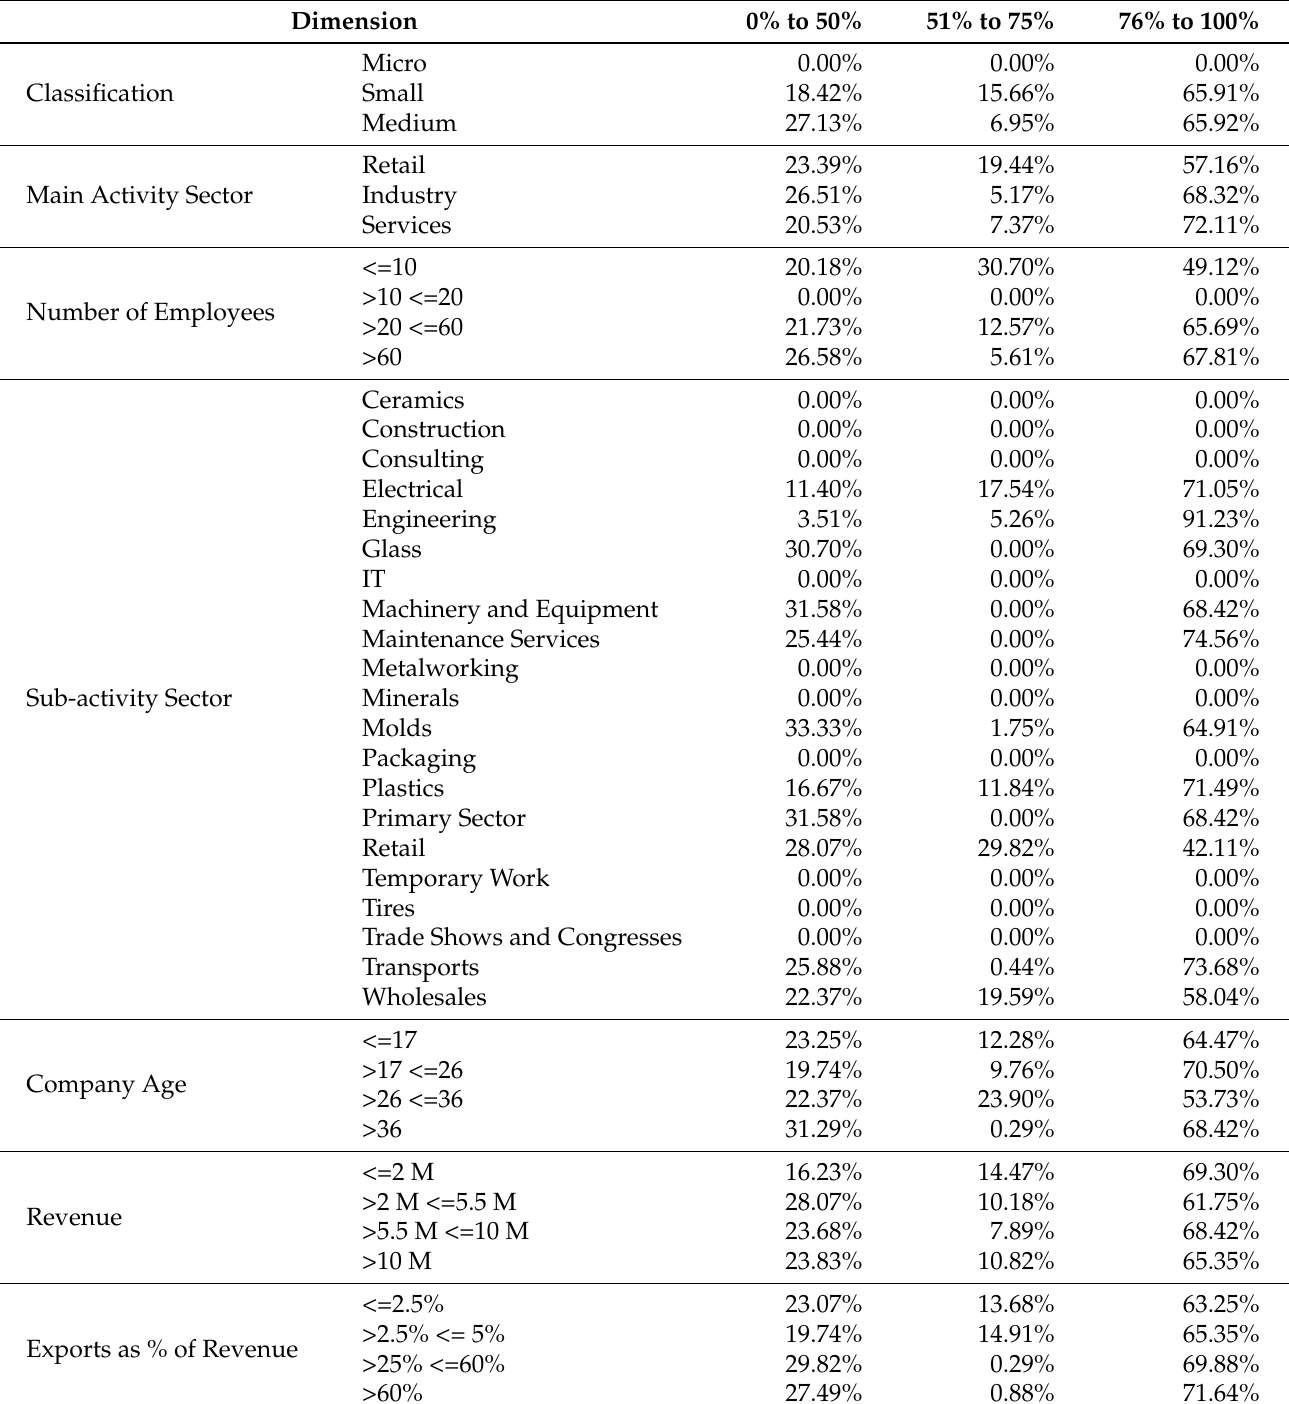
Table 4. Type 2—Second Audit—Acceptance percentage intervals of the controls in the predefined